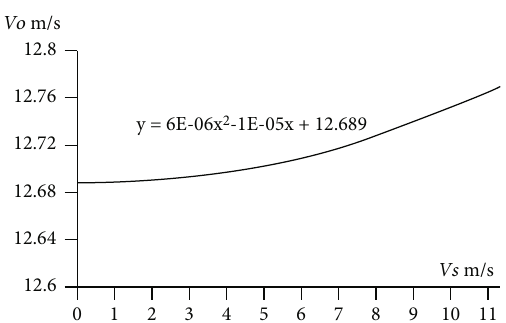
Figure 6: Changing curve of fl ow velocity at the borehole outlet with aquifer velocity of